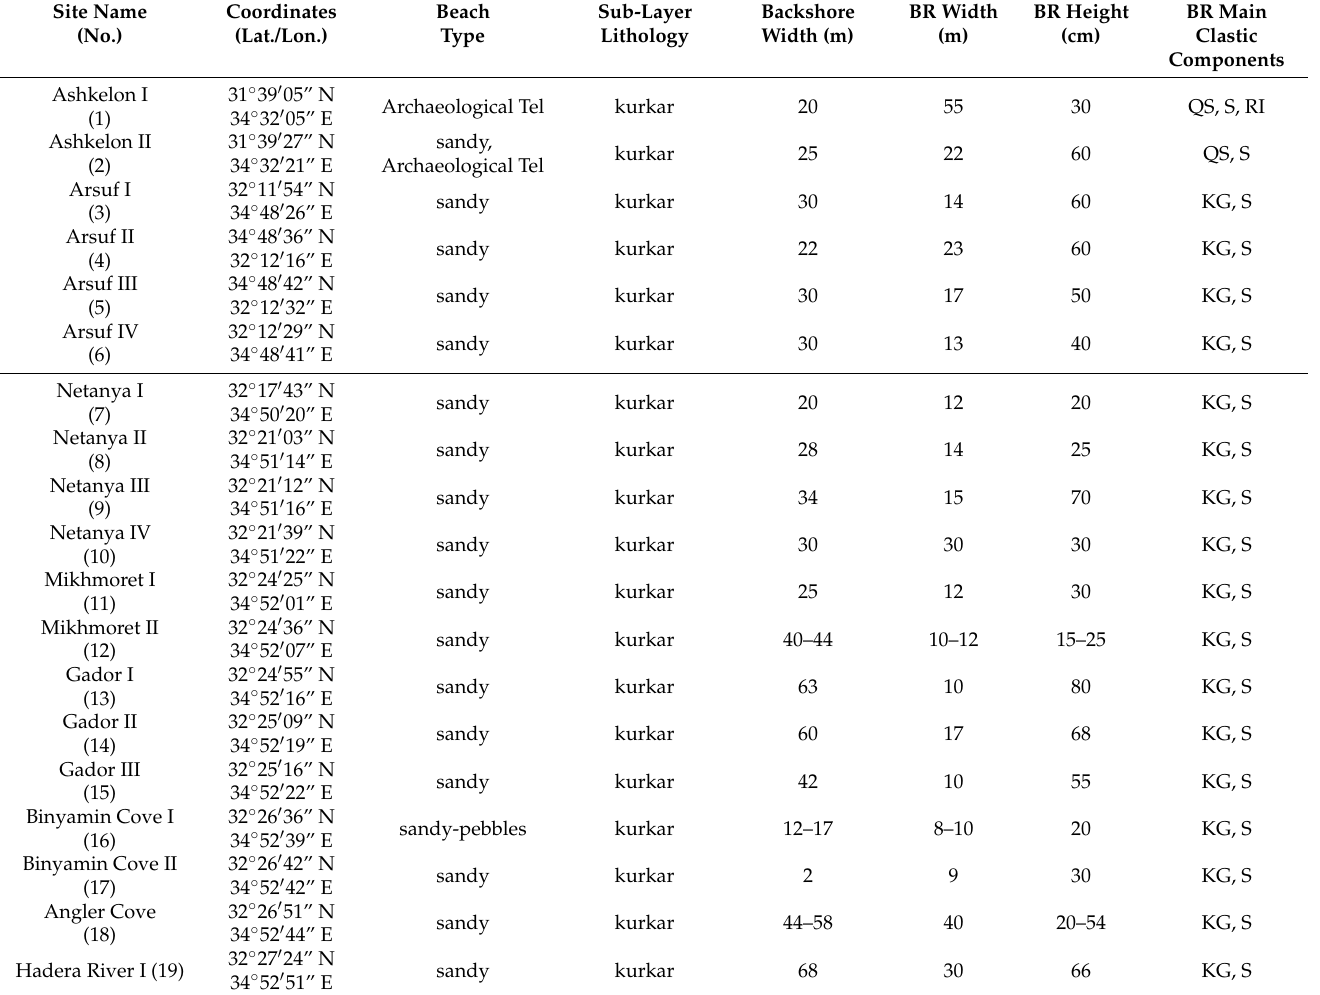
Table 1. Selected BR outcrop sites along the Mediterranean coast of Israel: Locations and physical properties at transects studied. (Main clastic components: BS: biogenic sand; S: shells; RI and CI: rock, and ceramic inclusions; KG: kurkar granule; QS: quartz sand).